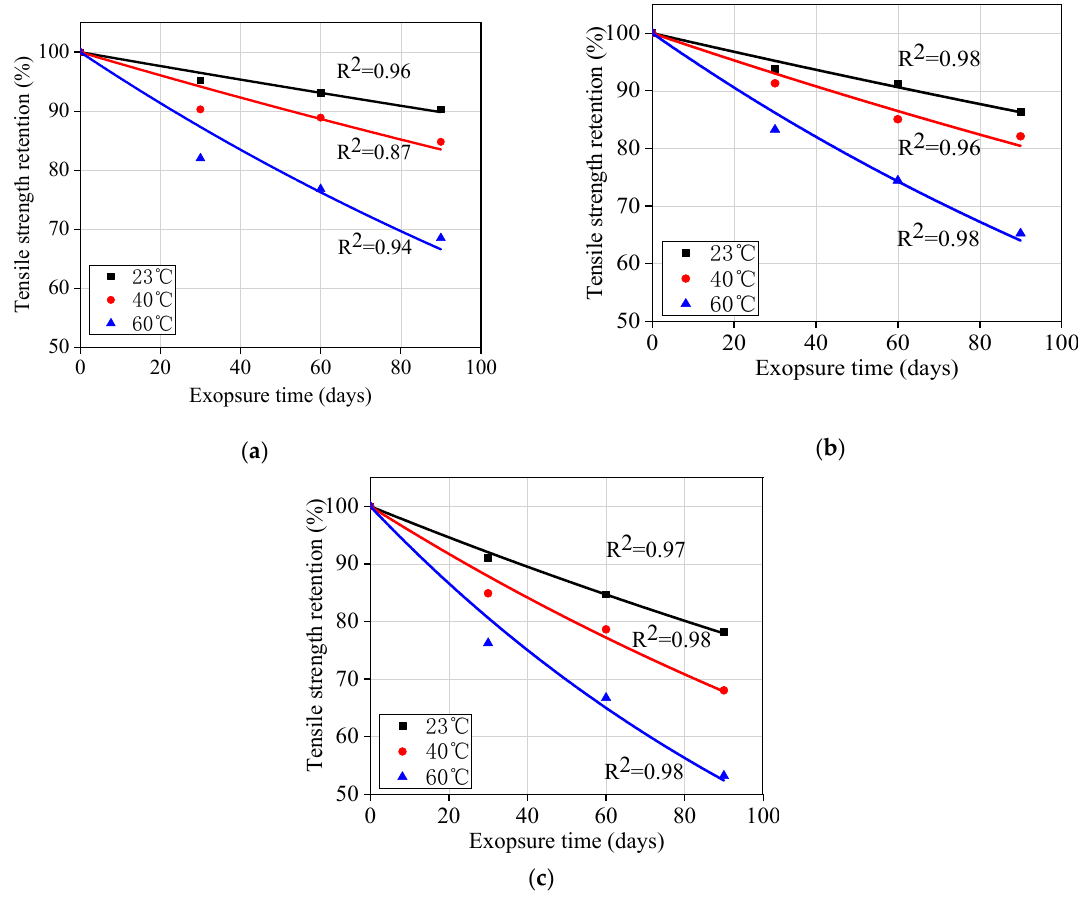
Figure 12. Fitted curves for tensile strength retention versus time: ( a ) 0% stress level; ( b ) 20% stress; ( c ) 40% stress